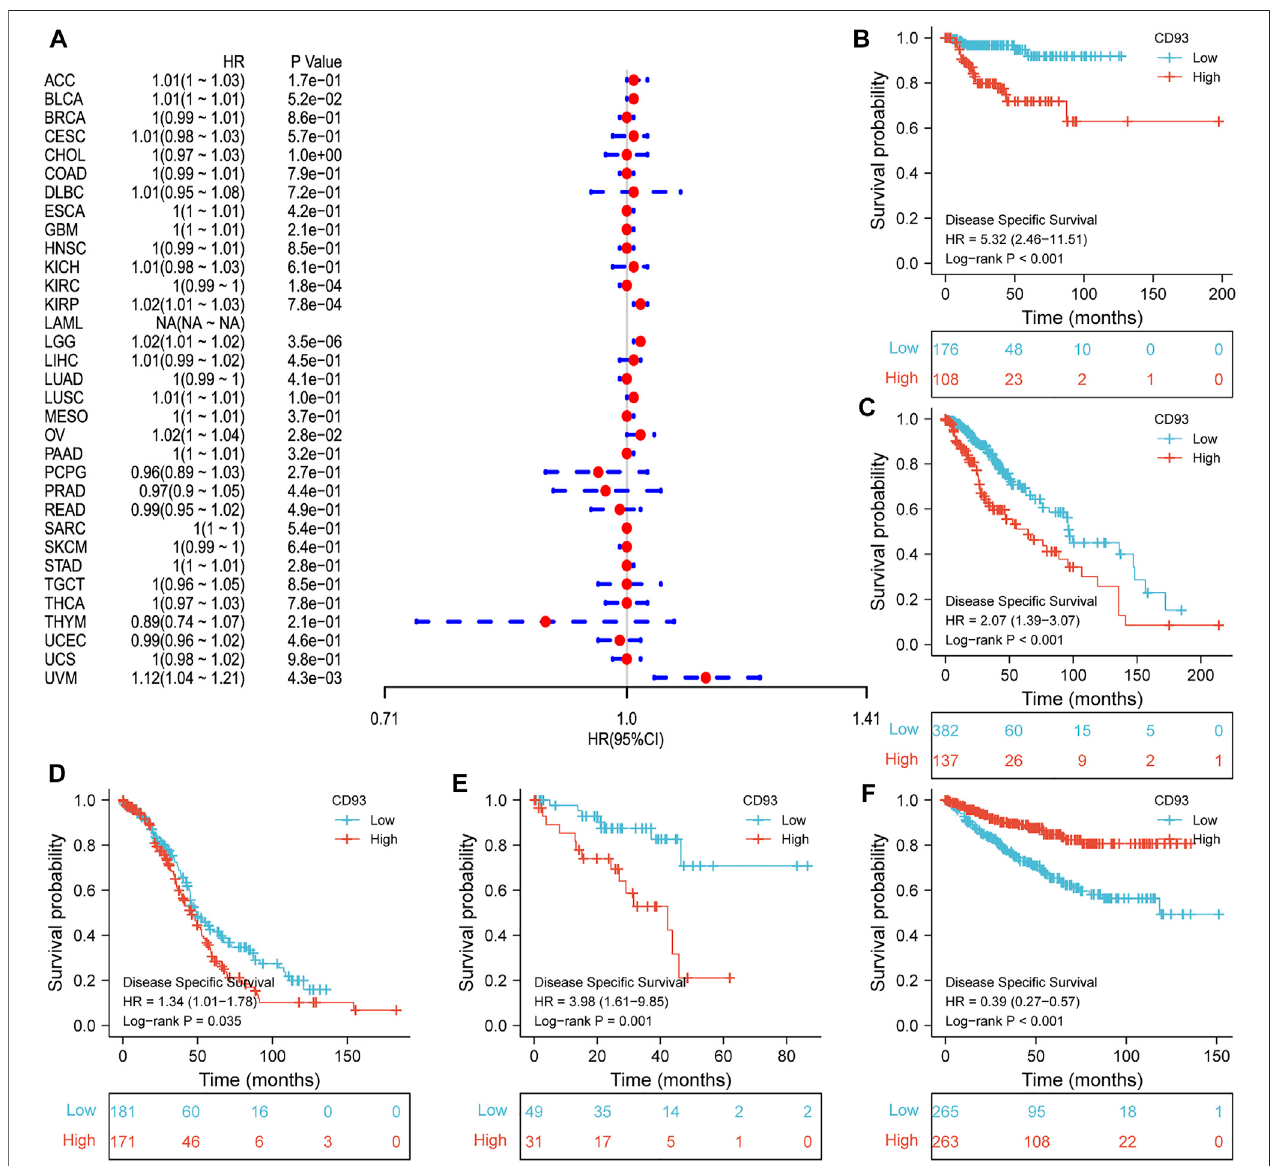
FIGURE 3 | Association between CD93 and DSS. (A) Forest plot of DSS associations in 33 types of tumors. (B – F) Kaplan – Meier analysis of the association between the CD93 expression and DSS in KIRP, LGG, OV, UVM, and KIRC.